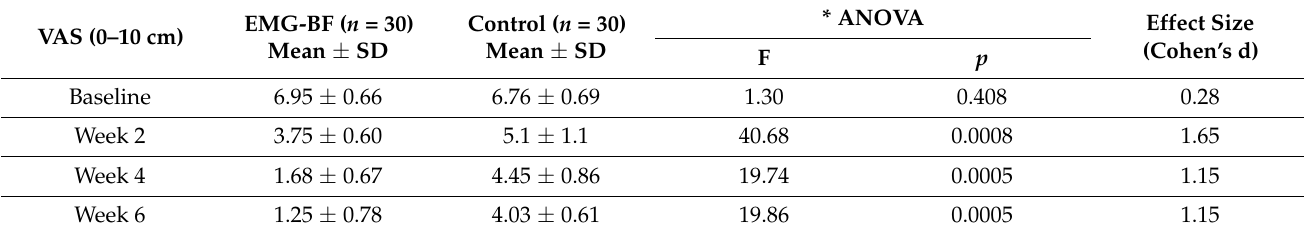
Table 2. Comparison of visual analog scale (VAS) scores between the two groups.